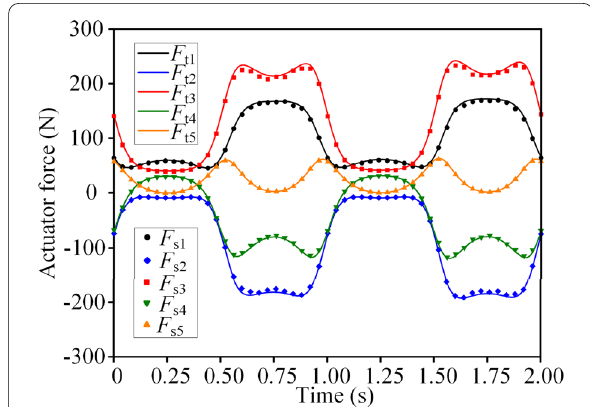
Figure 11 Comparison of simulation and theoretical actuator forces ( F t , Theoretical force; F s , Simulation force)